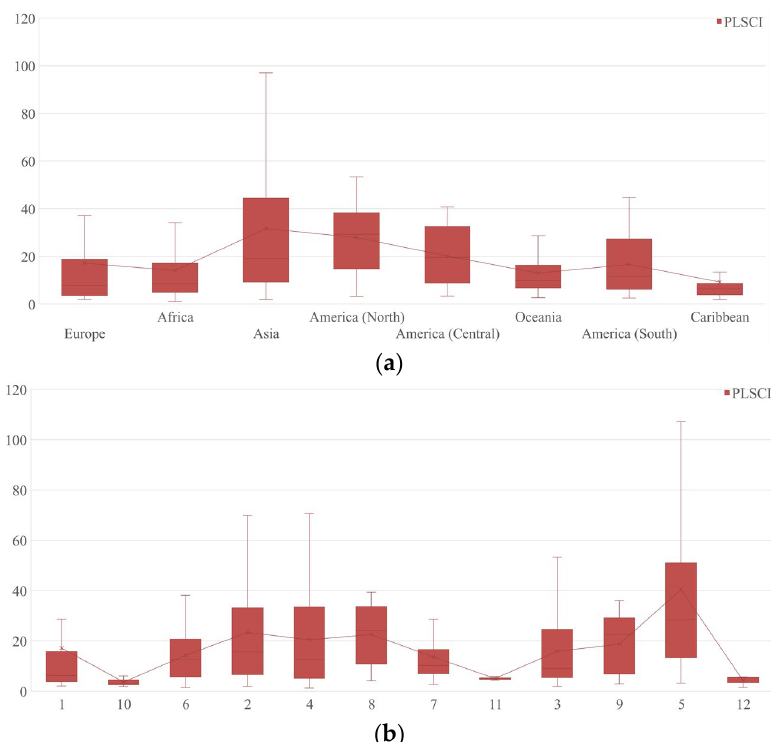
Figure 7. Box plots for PLSCI of ports in GLSN. Several ports (20) that were not matched to a PLSCI are excluded from this figure. ( a ) Box plot for PLSCI of ports in different continents; ( b ) Box plot for PLSCI of ports in different